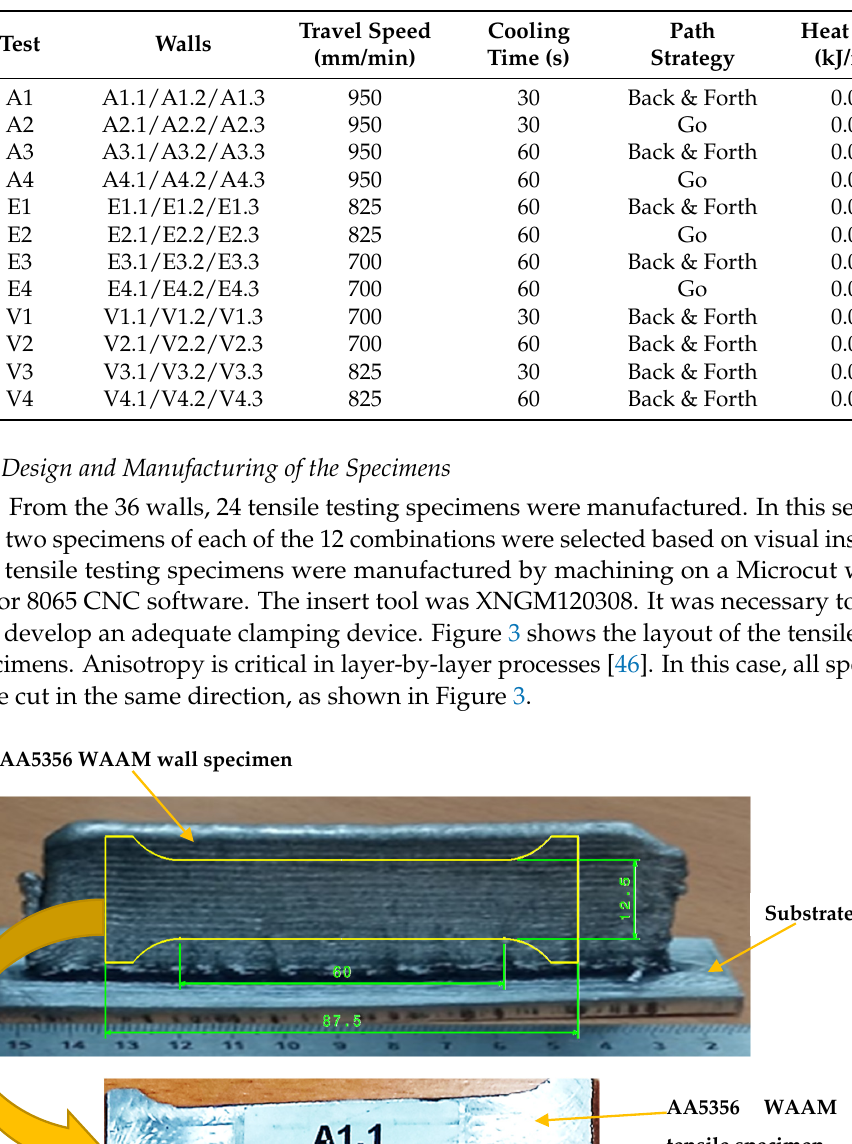
Table 4. Design of experiments for wall manufacturing.